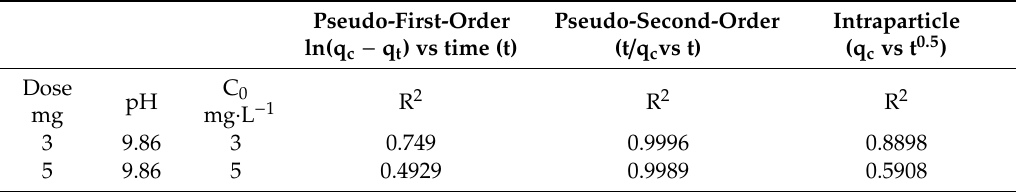
Figure 11. Plots of ( a ) Frendlich isotherm and ( b ) Langmuir isotherm models for Al 3+ adsorption.